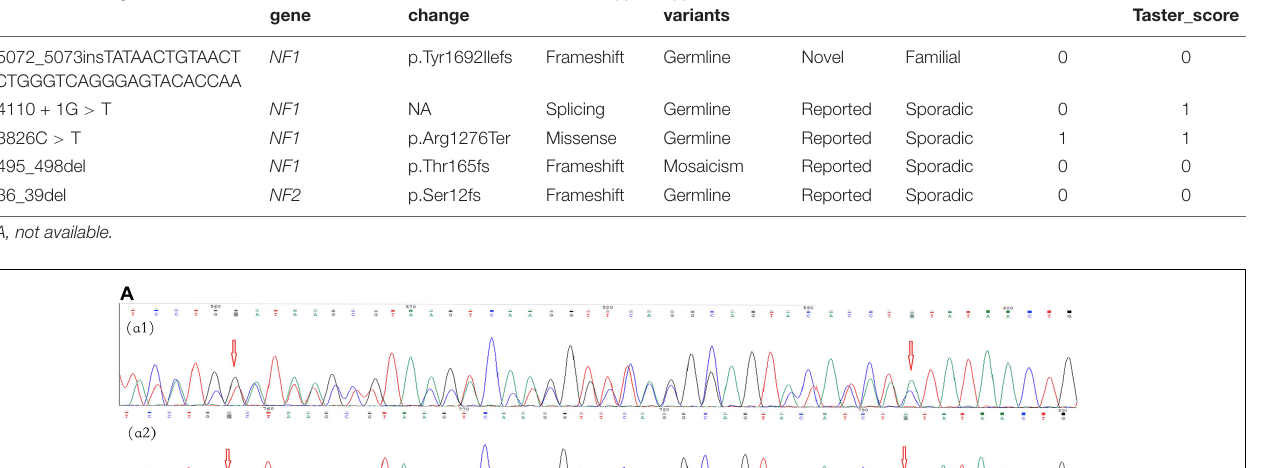
TABLE 2 | Variants identified of neurofibromatosis in this study. Nucleotide change Mutation